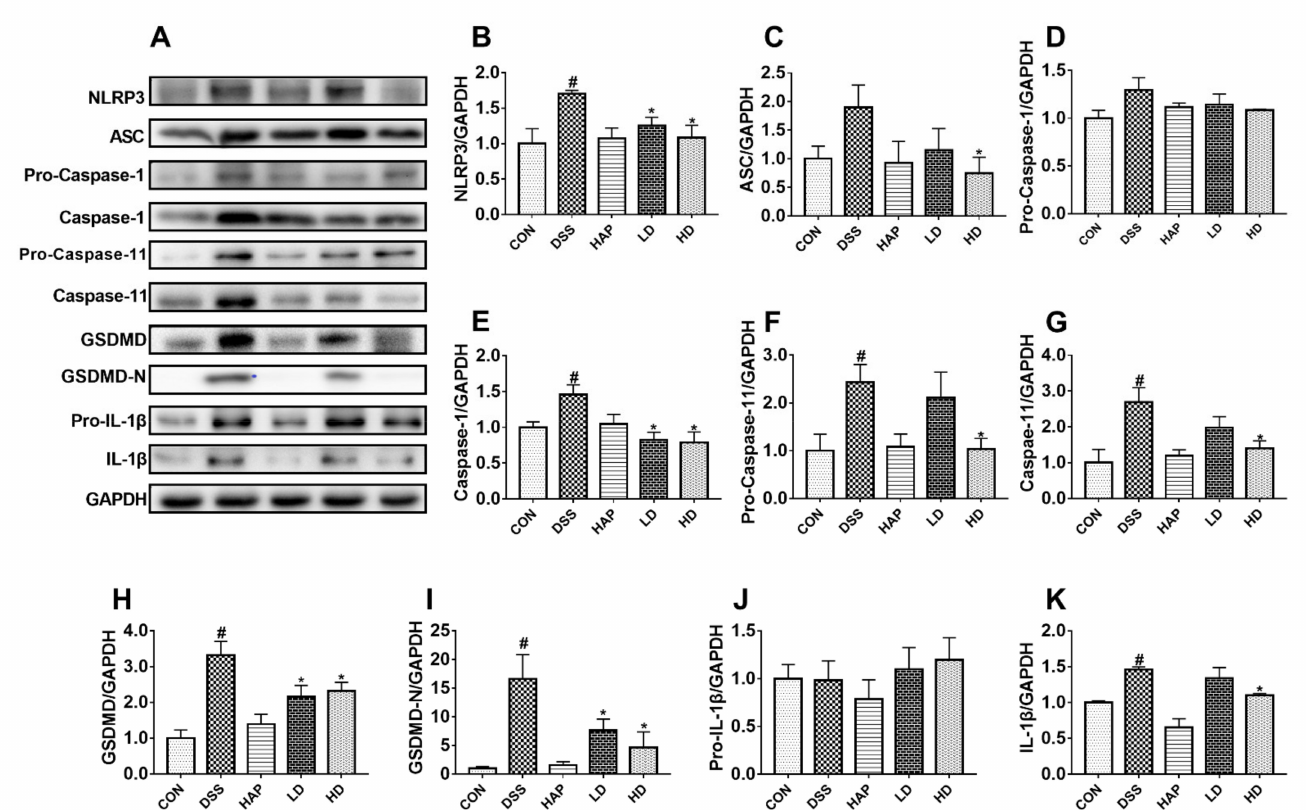
Figure 7. Effect of APE on the pyroptosis signaling pathway: The levels of (NOD)-like receptor family and pyrin domain containing 3 (NLRP3) ( B ), apoptosis-associated speck-like protein (ASC) ( C ), Pro-Caspase-1 ( D ), Caspase-1 ( E ), Pro-Caspase- 11 ( F ), Caspase-11 ( G ), gasdermin D (GSDMD) ( H ), GSDMD-N ( I ), Pro-IL-1 β ( J ) and IL-1 β ( K ) in colon tissue were measured by Western blot ( A ). n = 8 or 9. # p < 0.05 vs. CON group. * p < 0.05 vs. DSS